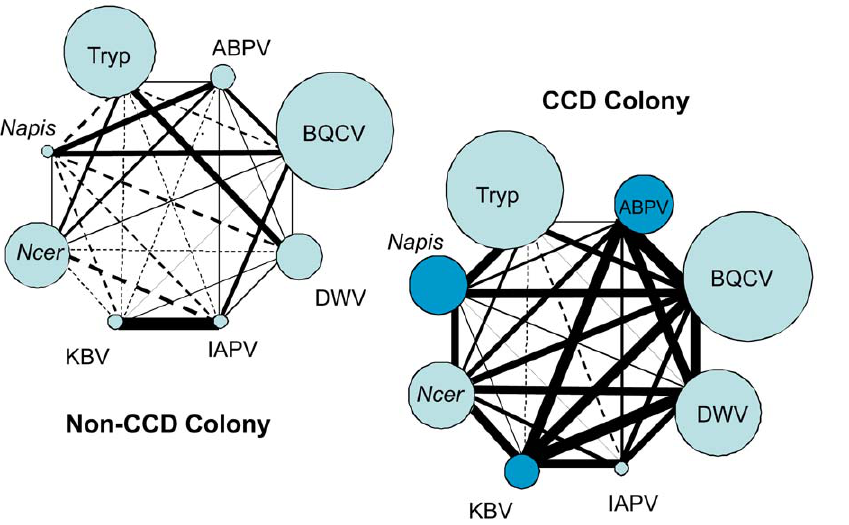
Figure 1. Graphical representation of pairwise correlations between pathogen abundance in CCD and non-CCD colonies. The thickness of lines is scaled to the Spearman’s rho correlation coefficient for each pair, the values of which are given in Table